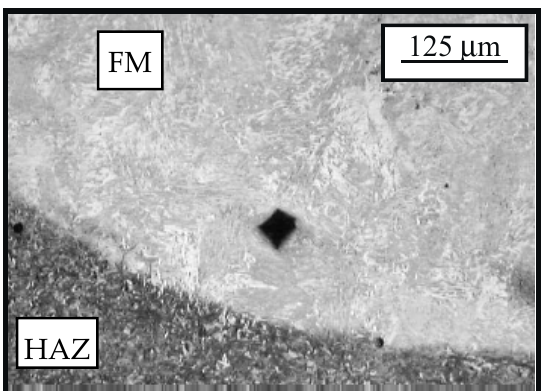
Figure 3. Microstructure of the transient zone from the cemented (bright field) hard-faced layer with the filler metal EVB2CrMo (FM) and the heat affected zone (HAZ) of the base metal (BM) (dark field)—state: hard-faced + soft annealed + cemented + heat treated. Since the exploitation characteristics of the hard-faced layer depend, to a great extent, on the size of dendrites within it, the dendritic crystals’ width was measured on the optical microscope [26]. Those measurements were performed at a distance of 0.2 mm from the joint line, as shown in Figure 4. A total of 217 dendritic crystals were measured over